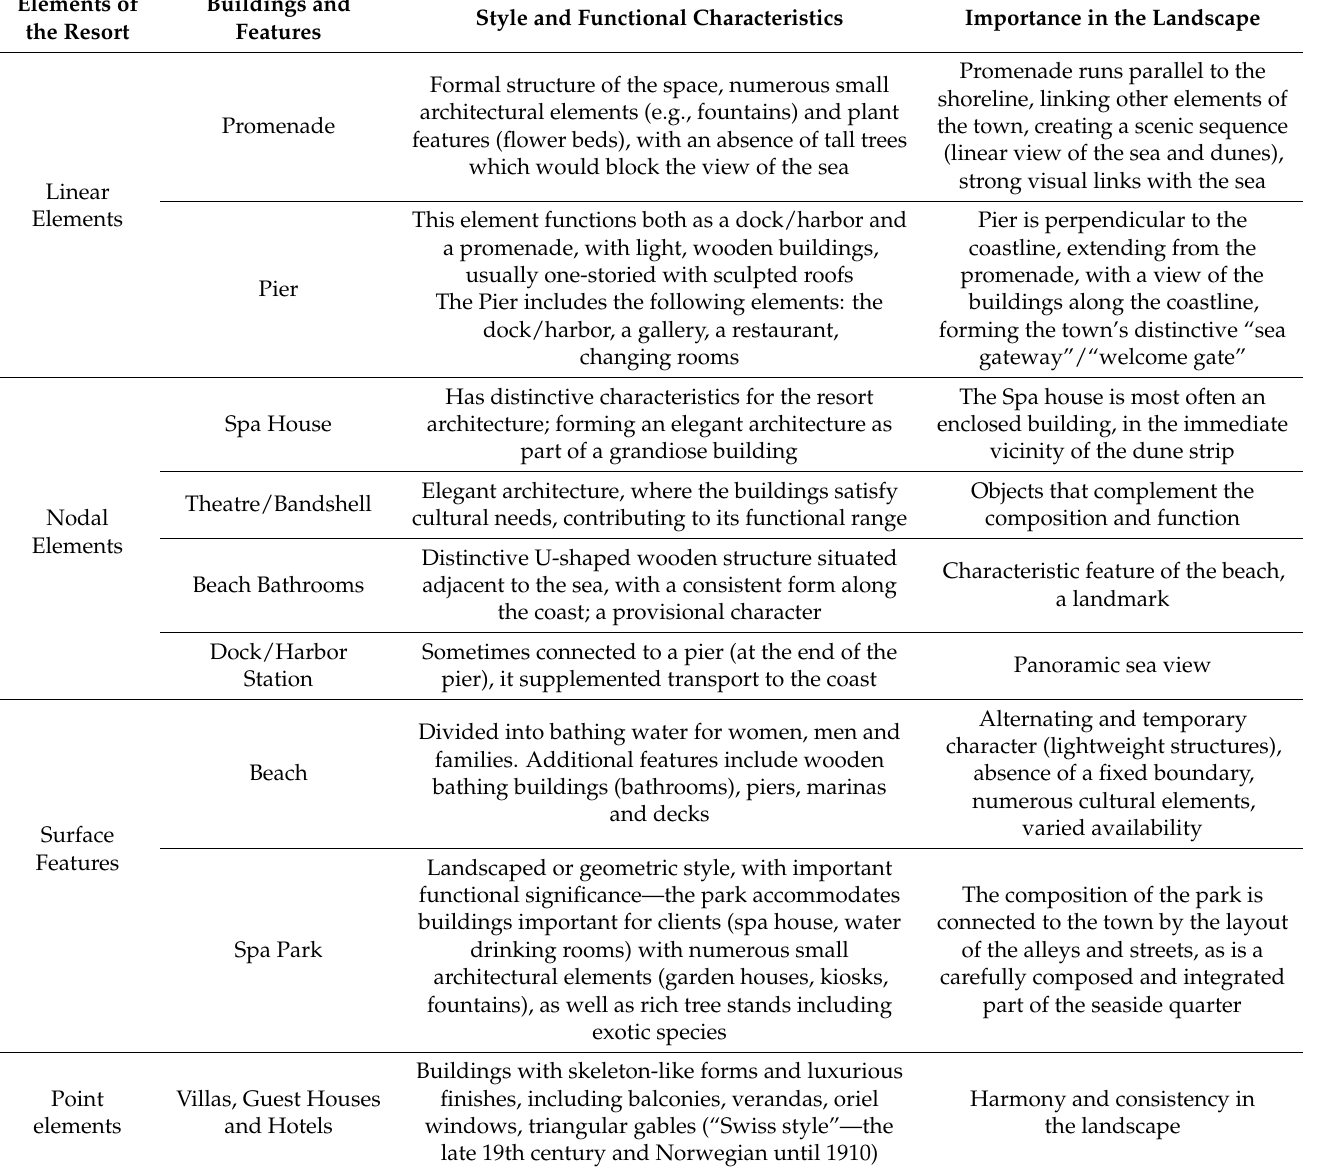
Table 1. The key compositional elements and characteristics of a mature seaside resort. Source: Authors’